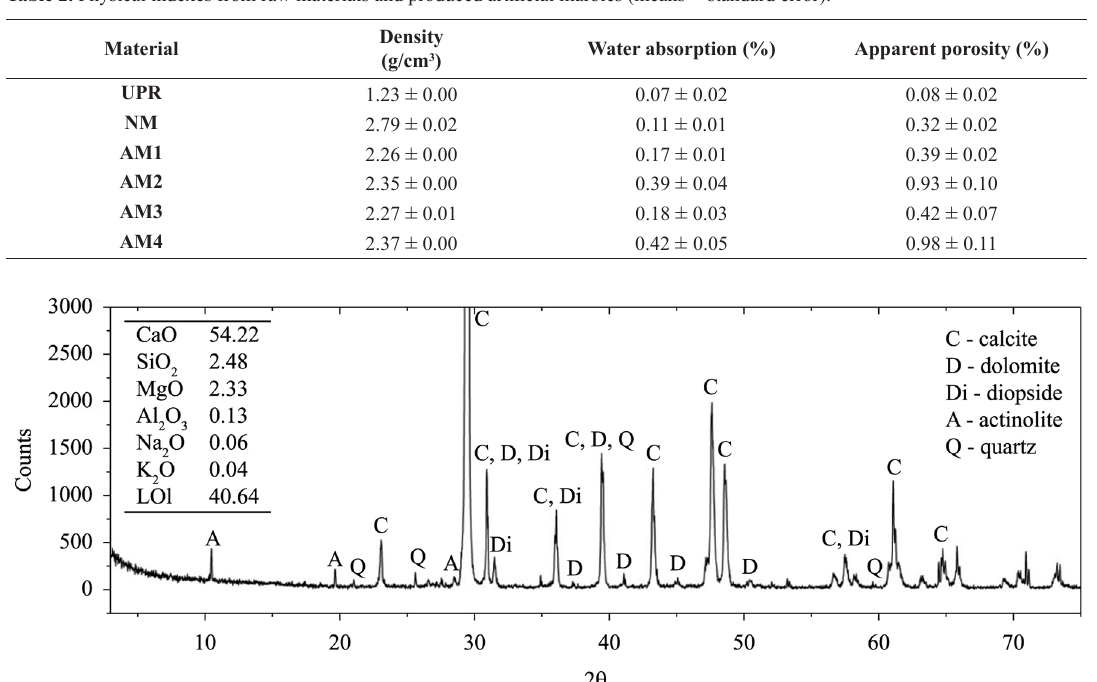
Table 2. Physical indexes from raw materials and produced artificial marbles (means ± standard